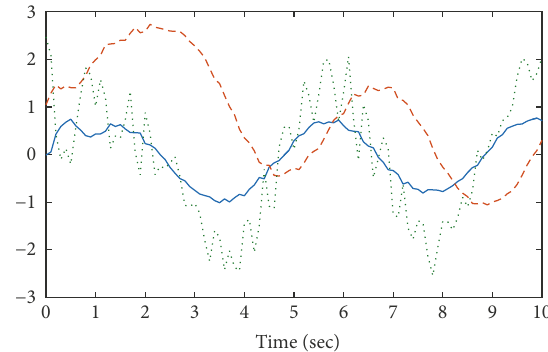
Figure 15: State variables ̇𝑞 1 (-), 𝑞 2 (- -), and ̇𝑞 2 (-.-) of Baxter robot.